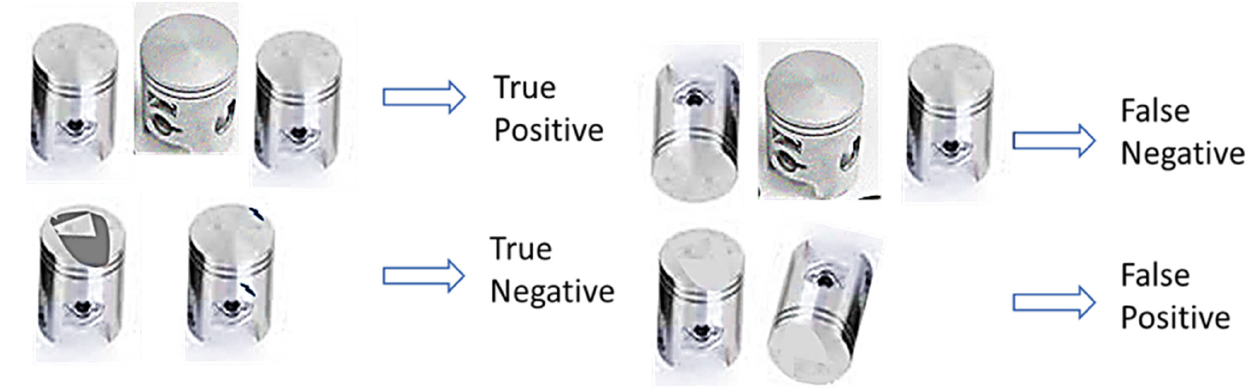
Figure 3. True positive, false negative, true negative, and false positive samples of the AC pistons.